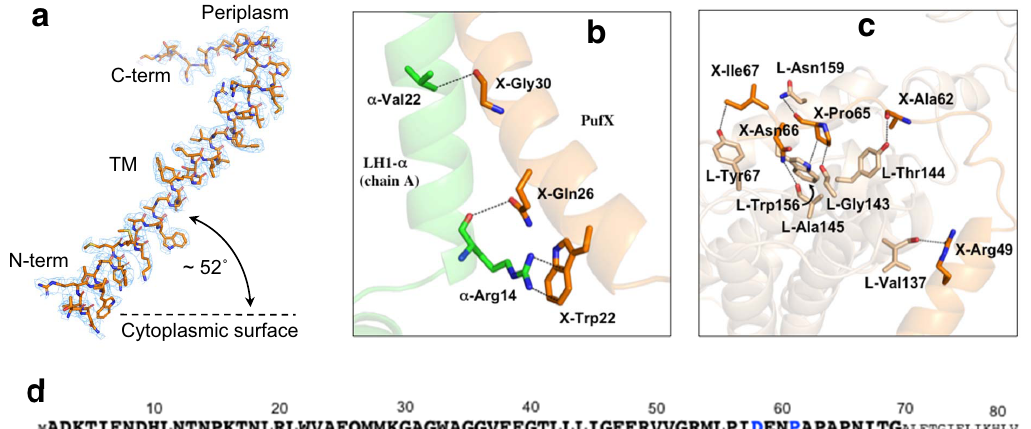
Fig. 3 Structure and interactions of Rba. sphaeroides PufX. a Structure and density map (3.0 σ ) of PufX with orientation toward the presumed membrane plane. b Close contacts (<3.5 Å, dashed lines) between the PufX N-terminal region (transparent orange) and an LH1 α -polypeptide (chain ID: A, transparent green). c Close contacts (<3.5 Å, dashed lines) between the PufX C-terminal domain (transparent orange) and the RC L-subunit (transparent wheat). d Primary sequence of the full-length PufX in Rba. sphaeroides IL106. Sequence for the expressed PufX is shown by larger bold fonts. Membrane- spanning residues are underlined. The Glu58 and Pro61 (blue fonts) are both replaced by Gln in the type strain